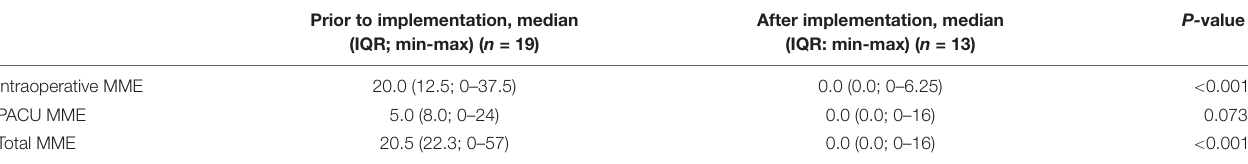
TABLE 2 | Summary of opioid consumption in oral morphine milligram equivalents.